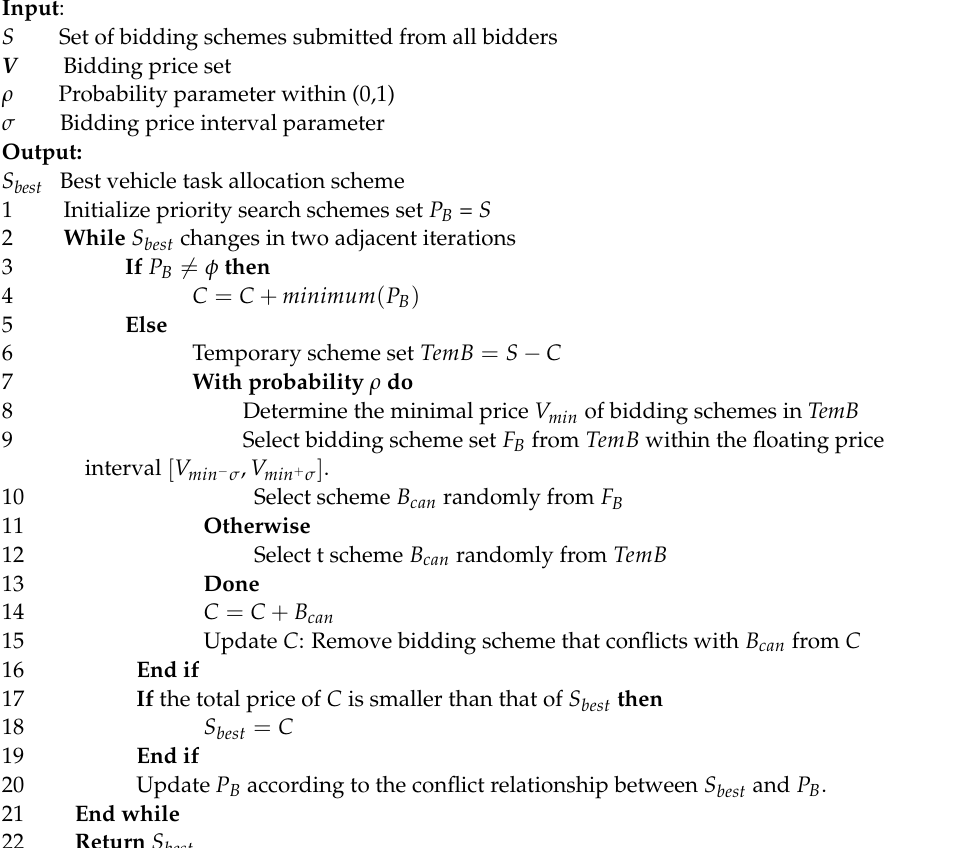
Algorithm 2 Priority-set-based local search